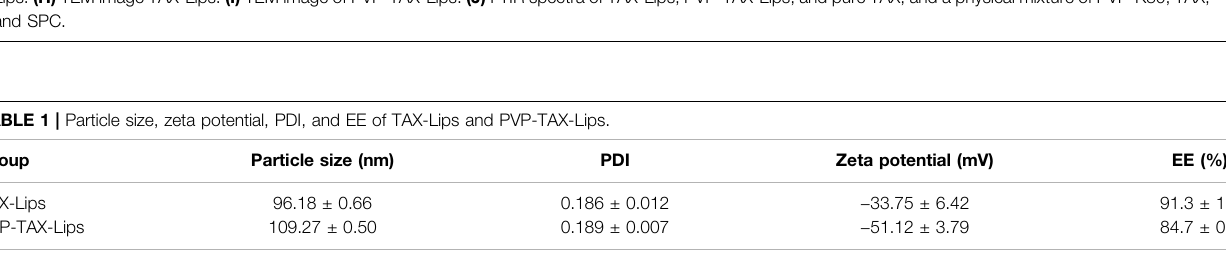
FIGURE 2 | Characterization of TAX-Lips and PVP-TAX-Lips. (A) The HPLC chromatogram of TAX standard. (B) The HPLC chromatogram of TAX-Lips. (C) The HPLC chromatogram of PVP-TAX-Lips. (D) Particle size of TAX-Lips. (E) Zeta potential of TAX-Lips. (F) Particle size of PVP-TAX-Lips. (G) Zeta potential of PVP-TAX-